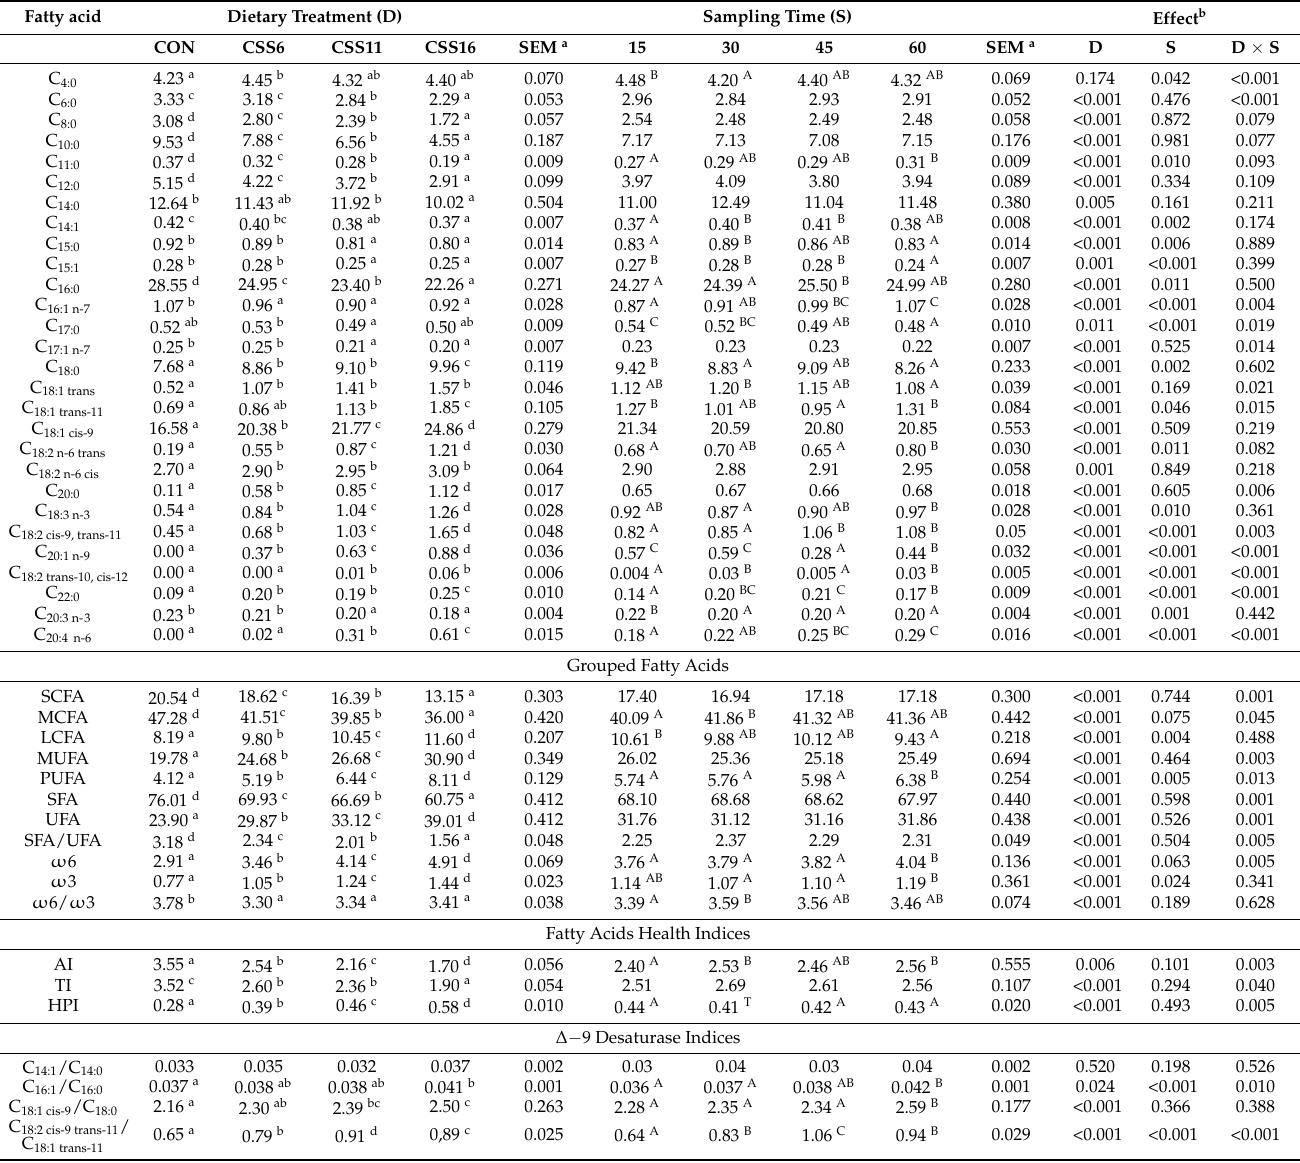
Table 4. The mean individual fatty acids (FA) (% of total FA), grouped FA, FA health indices, and ∆ -9 desaturase indices in the milk of ewes fed diets (CON, CSS6, CSS11, and CSS16) with different levels of Camelina seeds (6%, 11%, and 16% of concentrate) throughout the experimental period (15th, 30th, 45th and 60th experimental